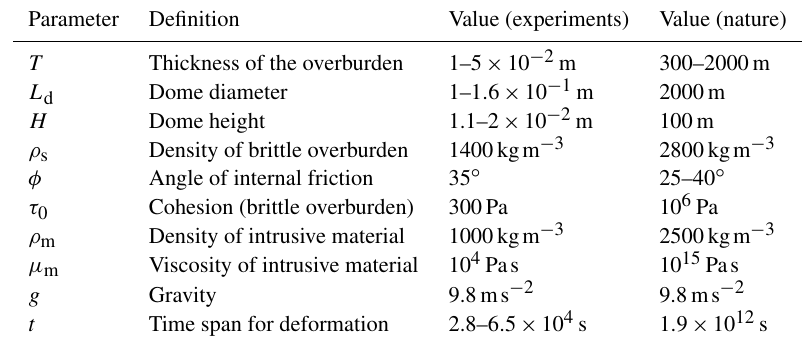
Table 2. Comparison of the geometric and material property parameters of the experiments and nature.